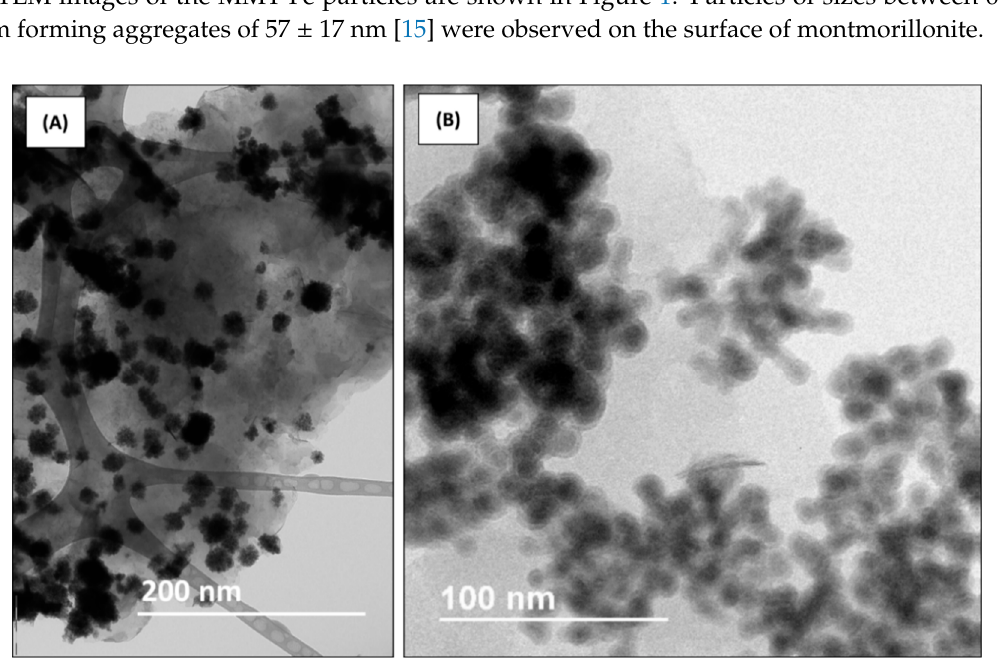
Figure 1. Transmission electron microscopy (TEM) images of MMT-Fe at different magnifications, showing the dispersion of the aggregates ( A ) and their microstructure ( B ).